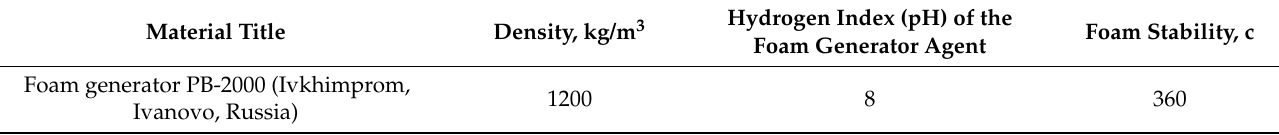
Table 4. Characteristics of the foam generator.